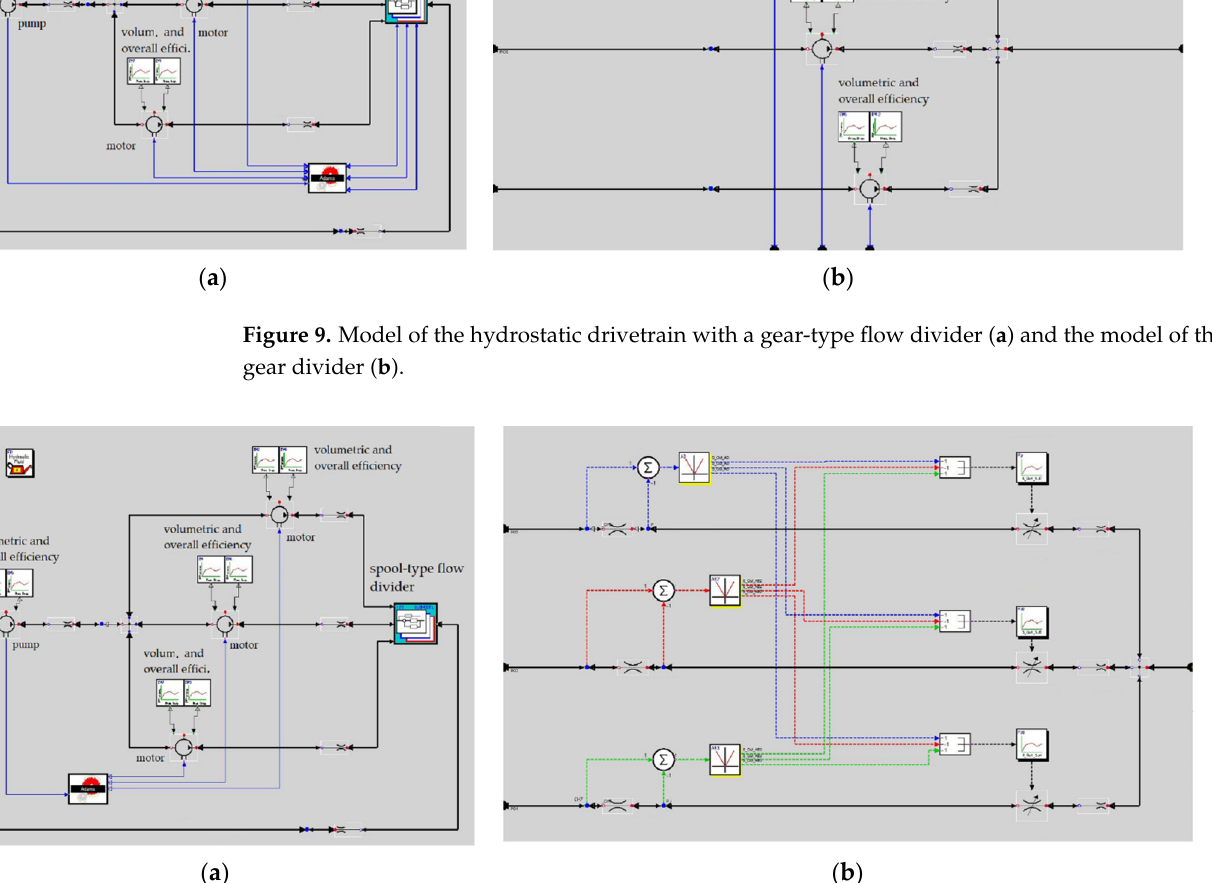
Figure 10. Model of the hydrostatic drivetrain with a spool-type flow divider ( a ) and the model of the spool divider ( b ). Table 3. Values of main hydrostatic drivetrain model